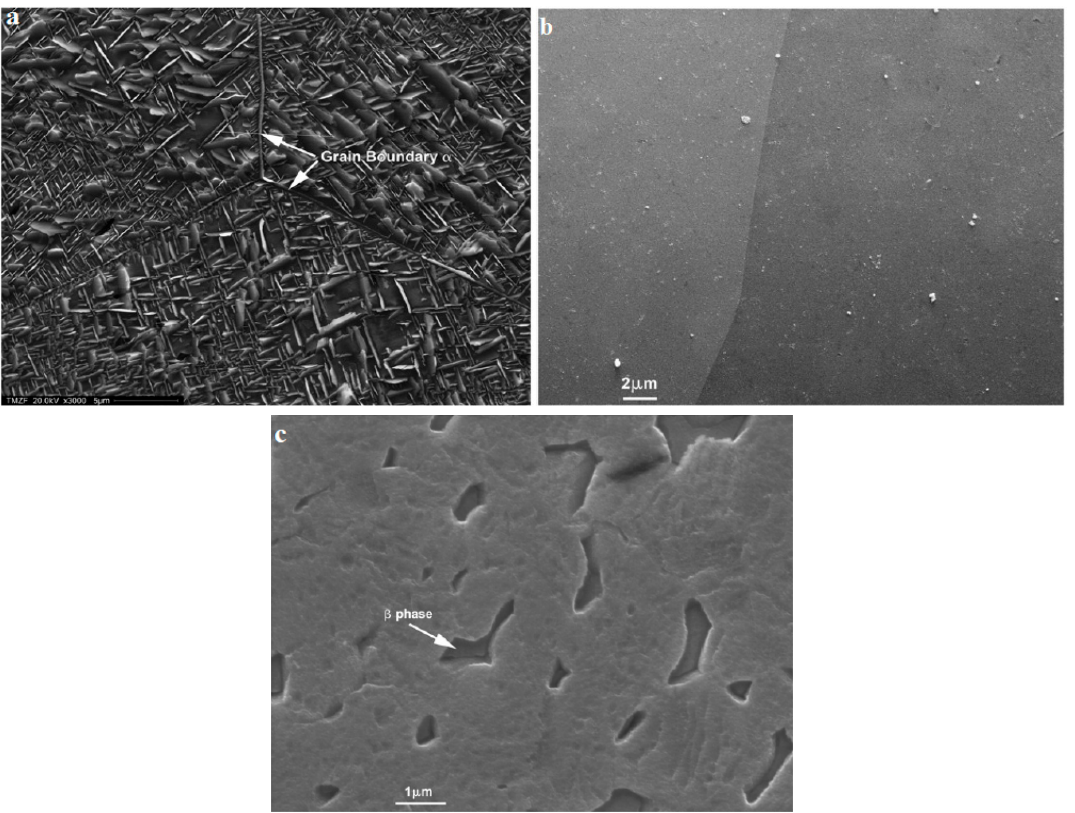
Figure 3. Secondary electron SEM micrograph of Ti-13Mo-7Zr-3Fe: ( a ) as-received α + β , ( b ) metastable β , following 50 h immersion in 5 M HCl at 37 °C, and ( c ) secondary electron SEM micrograph of the surface corrosion aspects of Ti-6Al-4V ELI (extra-low interstitial) after 50 h immersion in 5 M HCl at 37 °C [40].